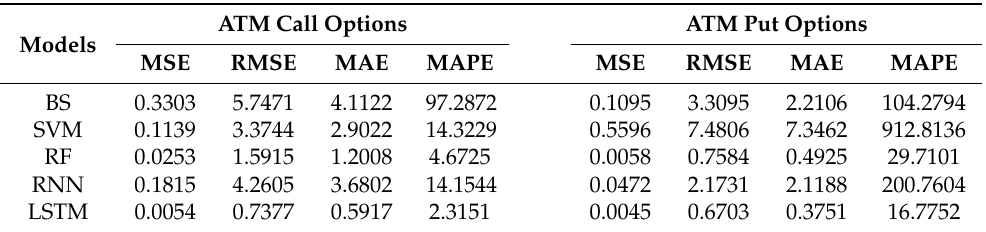
Table 12. Pricing error of ATM options estimated using different models when using realized skewness and realized kurtosis.